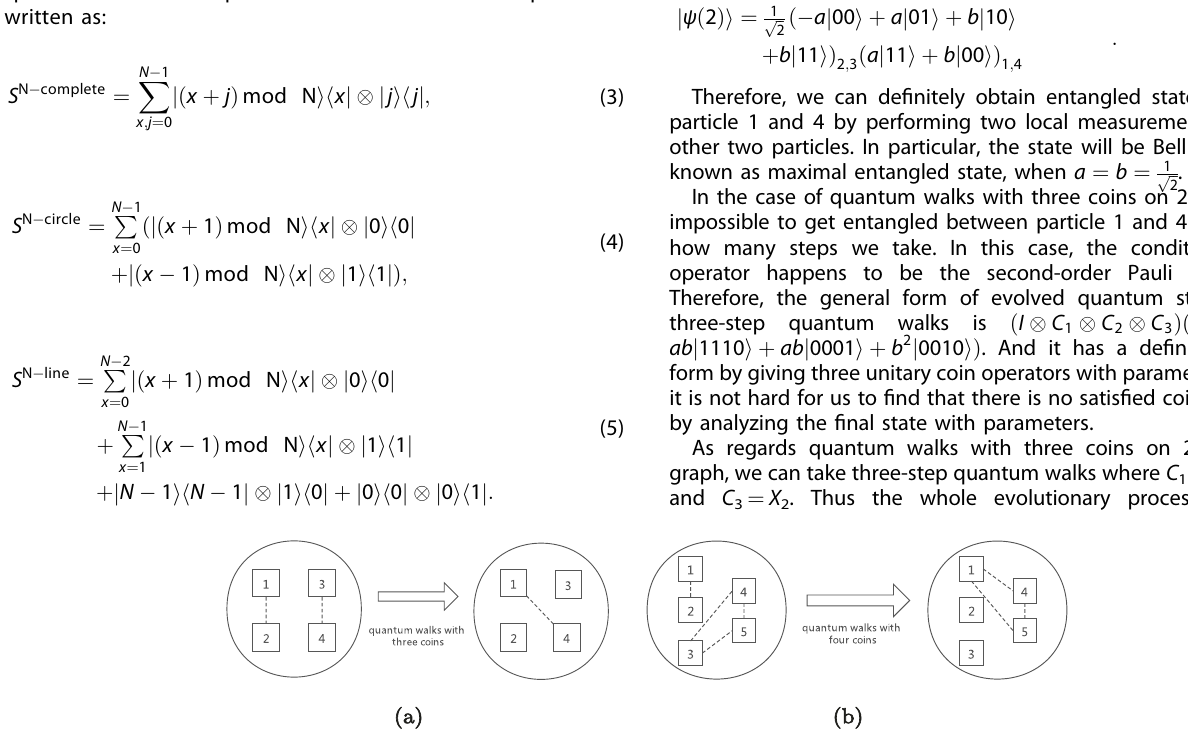
Fig. 1 The schematic diagram of our scheme. The small boxes indicate particles and the dotted lines indicate entanglement. a represents the generation of bipartite entangled state. b represents the generation of GHZ state. Due to the symmetry of the particles, any two or three unrelated particles can be entangled by our scheme. But for the sake of narration, let us take entanglement generation of particles 1, 4 and particles 1, 4, 5 as